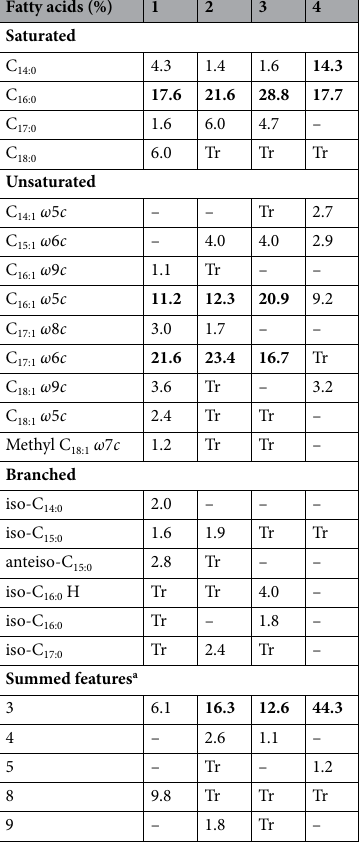
Table 3. Cellular fatty acid compositions of IMCC35004 T , IMCC35005 T , and the type strains of the